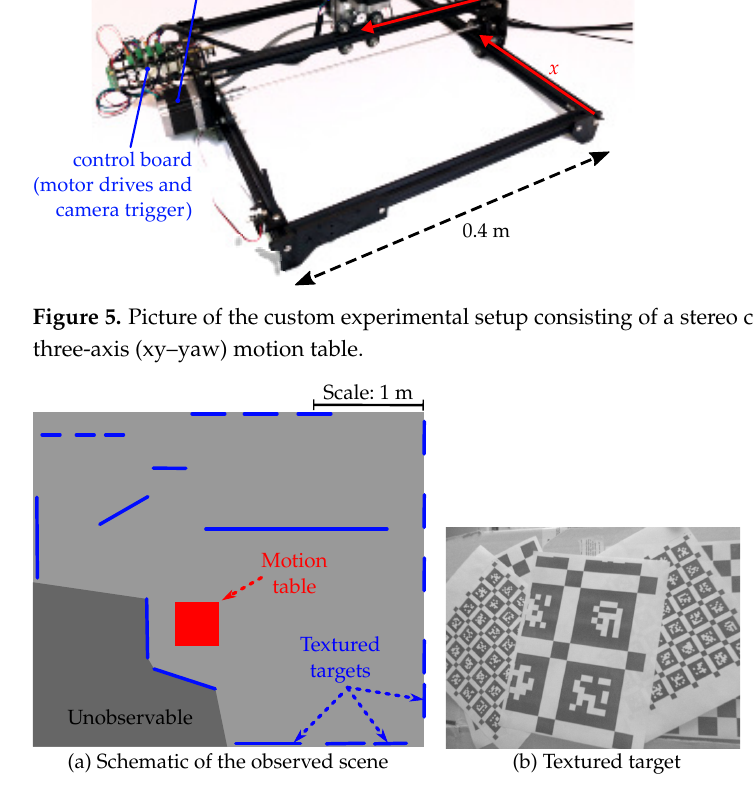
Figure 6. Details of the scene observed during the tests: ( a ) Schematic of the observed scene showing the approximate placement of the textured targets placed around the room. ( b ) Sample image of a textured target placed in the